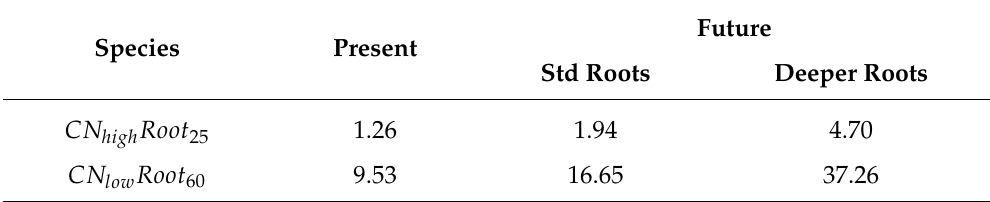
Table A3. Change in plant uptake inorganic N (kg[N]m − 2 year − 1 ). Taken as 10-year annual averages for present (2000–2010) with standard roots and future (2090–2100) under the RCP8.5 scenario for both standard roots and adapted roots which represent future root growth into deeper